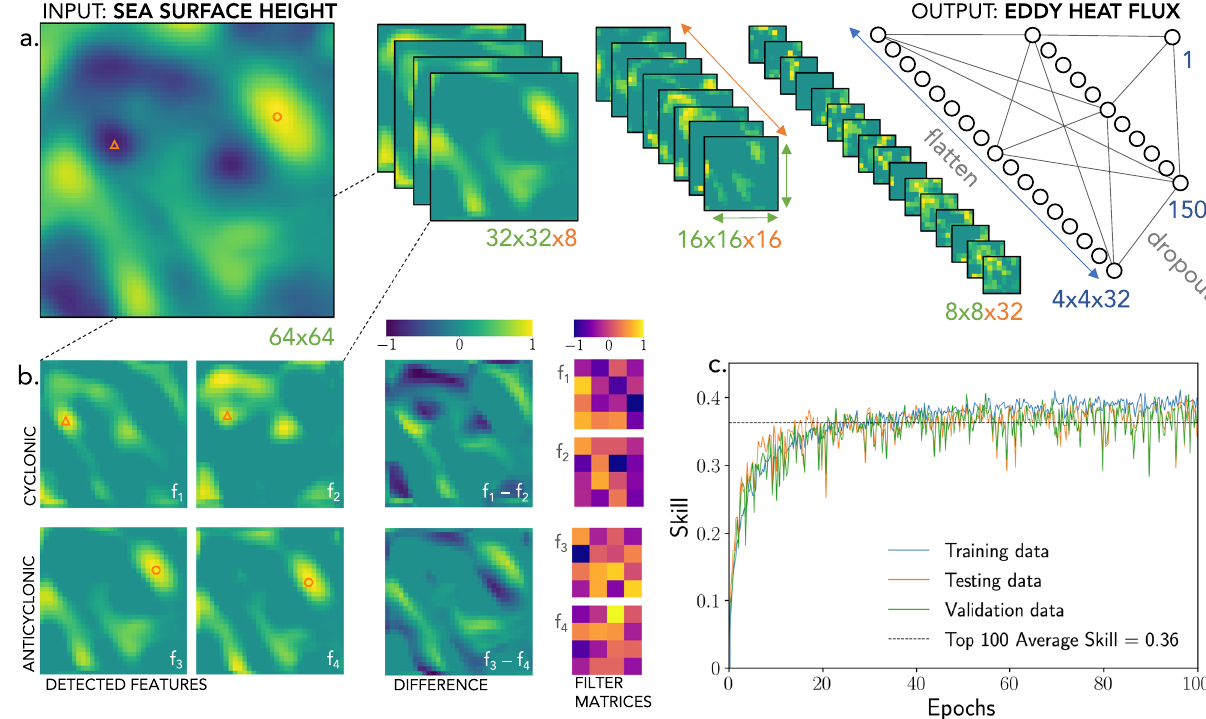
Fig. 2 The convolutional neural network architecture optimized to predict eddy heat fl uxes from sea surface height snapshots. a The architecture consists of multiple layers that consecutively fi lter the input, by convolution, with 4×4 weight matrices. The size of the feature maps (green numbers) is decreased layer-by-layer whilst the number of feature maps (orange numbers) is increased. More and more abstract features of sea surface height patterns are extracted at each subsequent layer. Finally, the features extracted by the fi nal layer of convolutional neural network are fl attened into a vector and passed into a two-layer fully connected neural network in order to predict the fl ux. All variables have been non-dimensionalised such that their extremal pixel has a value of modulus 1. b Example of the outputs from the fi rst convolutional layer after training. The left two columns, f i , show 4 of the 8 fi rst layer feature maps — we discover that they are split into cyclonic and anticyclonic fi lter groups. Also shown are differences between these feature maps (third column) as well as the corresponding 4×4 weight matrices (fourth column) which performs this fi ltering. The triangle/circle markers highlight example cyclonic/anticyclonic eddy centers. c The evolution of the neural network skill evaluated using the training (blue), testing (orange), and validation (green) datasets, plotted as a function of training epochs, i.e. the number of times we have iterated through the entire training dataset; the average validation skill corresponding to the top 100 training skills is shown with dashed gray